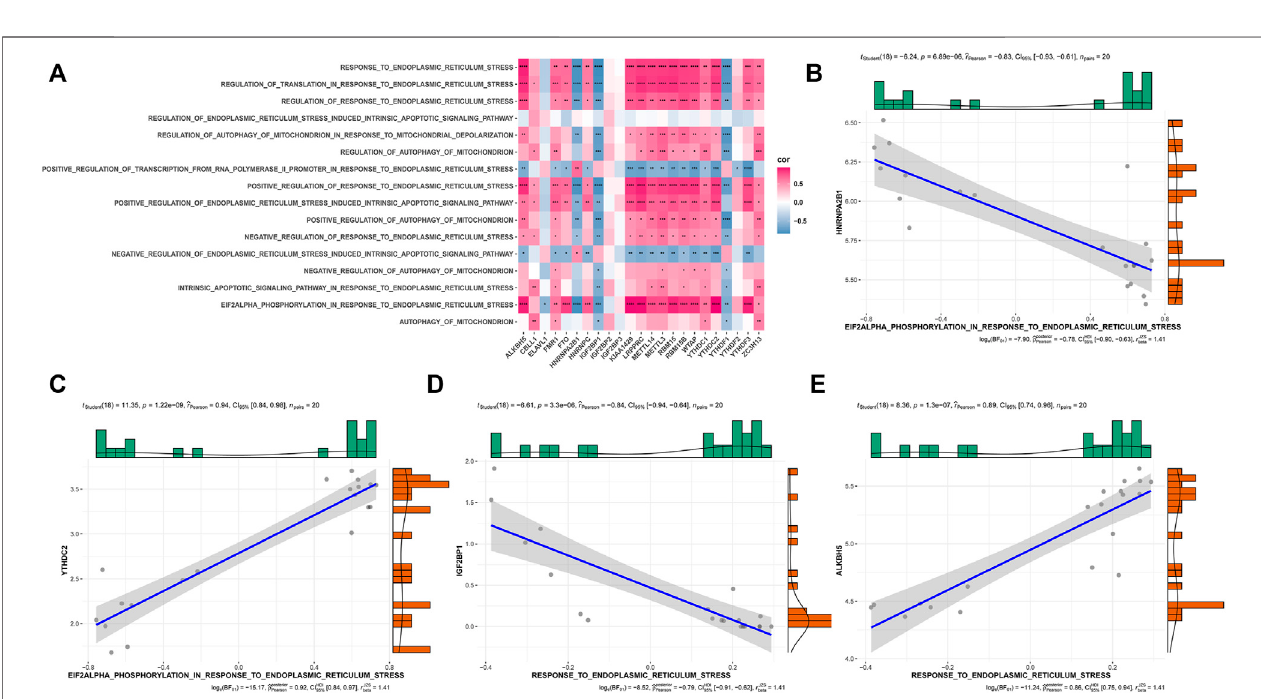
FIGURE 8 | Correlation of m6A gene expression and pathways related to endoplasmic reticulum stress and mitophagy in OA. (A) The overall heat map of the correlation between m6A gene expression and ER stress and mitophagy-related pathways. (B – E) The correlation between HNRNPA2B1, YTHDC2, IGF2BP1, and ALKBH5 gene expression and ER stress